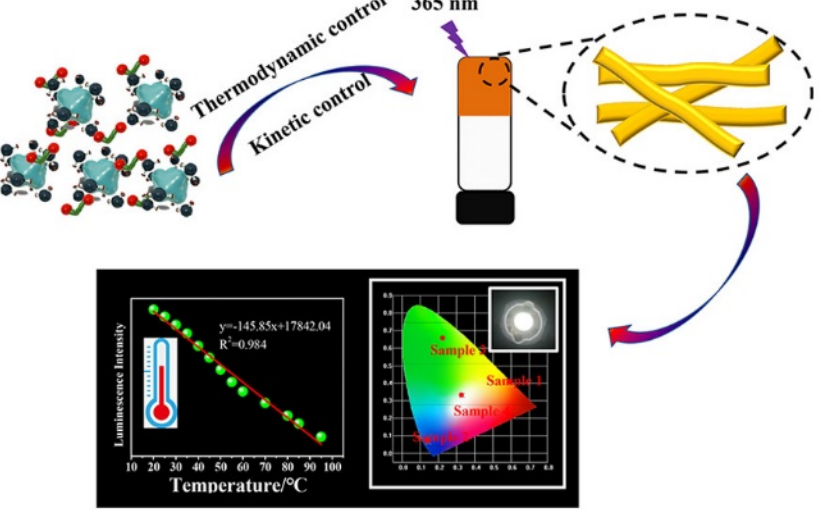
Figure 10. Ag 9 NCs/SA hydrogel can be used as a temperature-controlled detector and as a